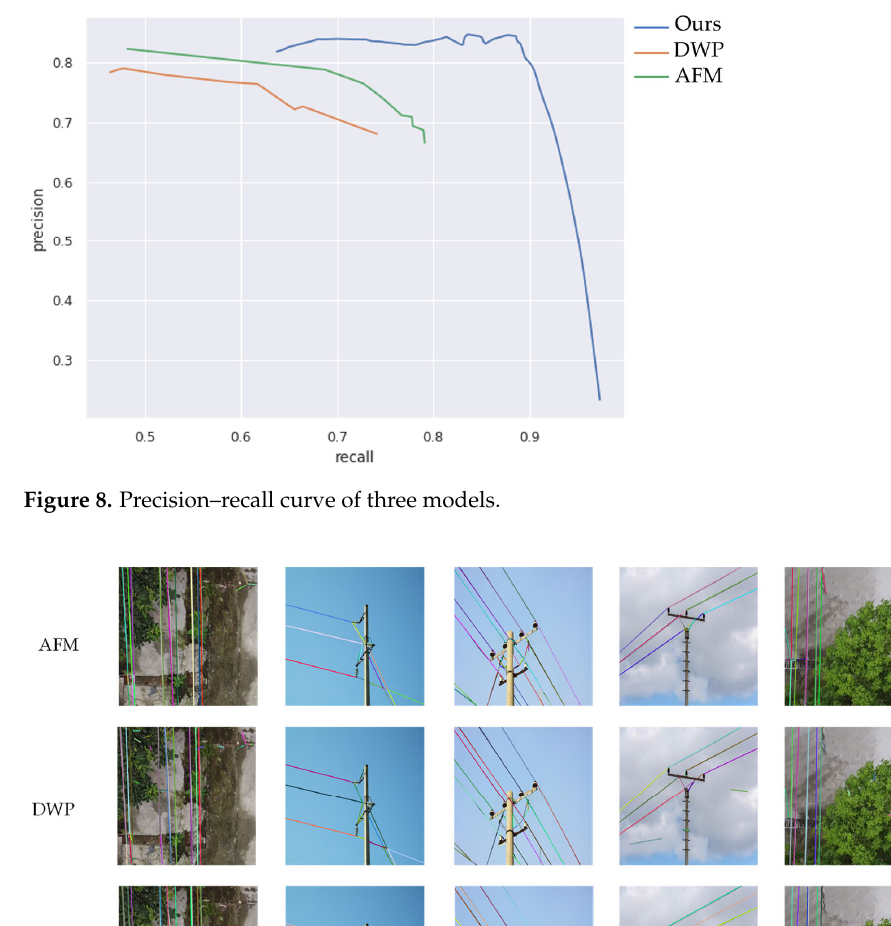
Figure 8. Precision–recall curve of three models.